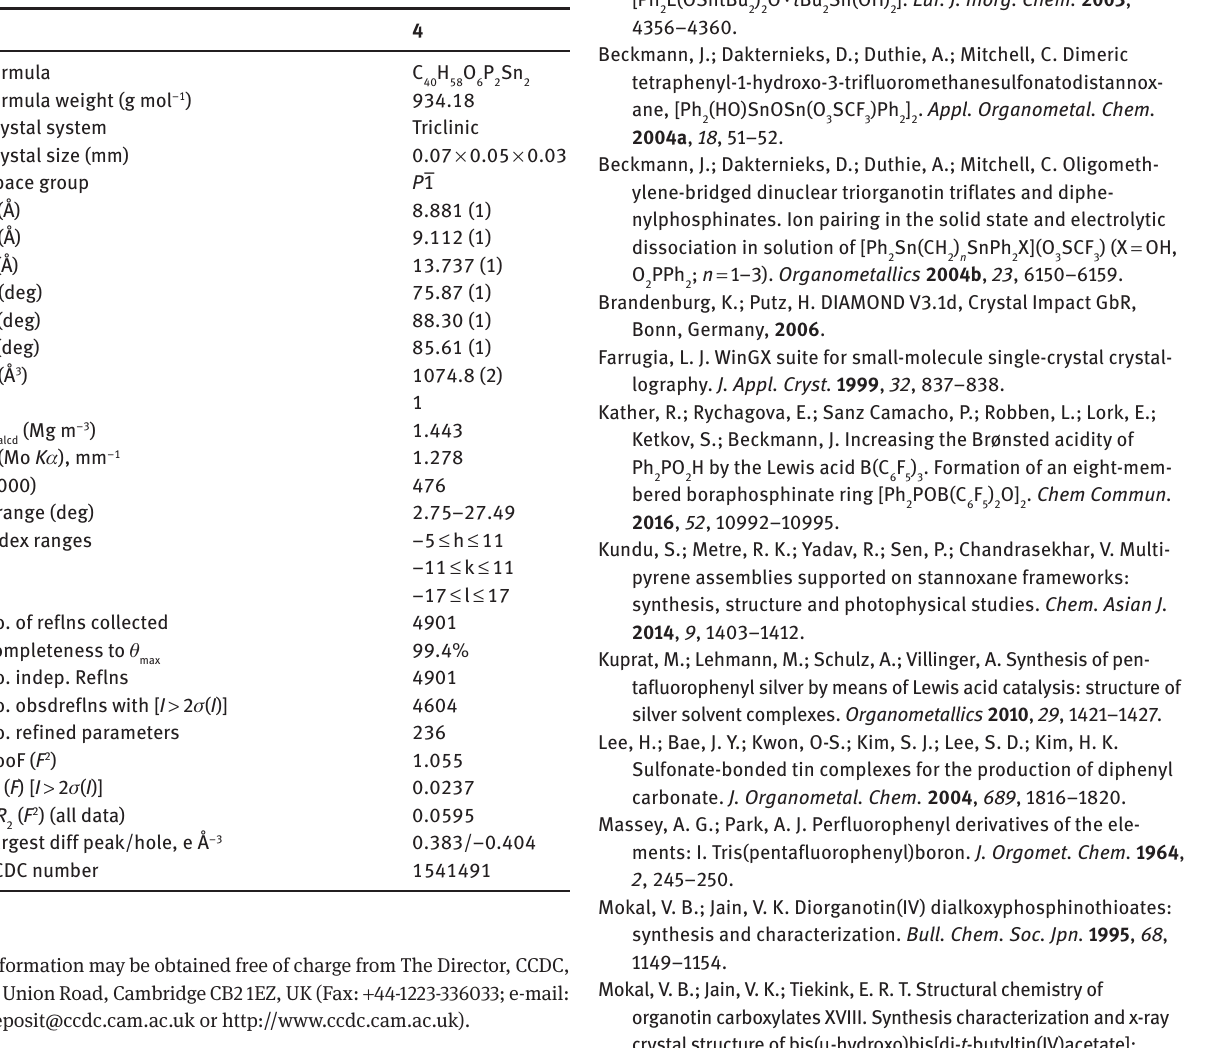
Table 1: Crystal data and structure refinement of 4